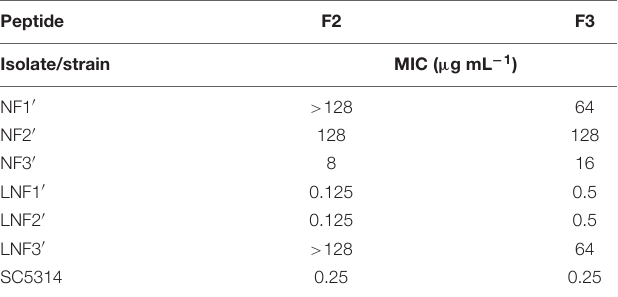
TABLE 9 | Stability of resistance to F2/F3 of NF1-3 and LNF1-3 isolates after 10 subsequent passages in YPD medium. MIC values were determined in YNB-SG. Peptide F2